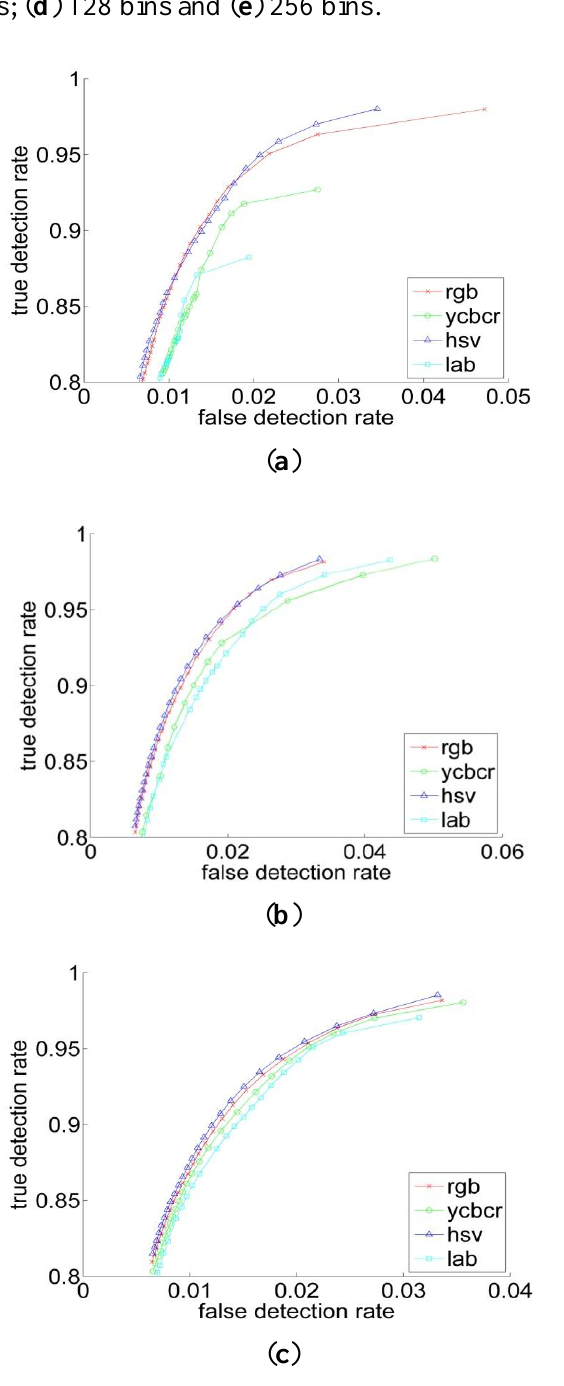
Figure 5. The ROC curves in the four color spaces for histogram resolutions of ( a )